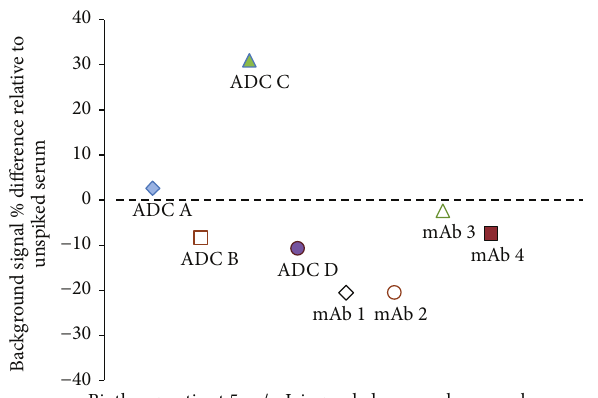
Figure 4: Background signal in pooled cynomolgus monkey serum differs across biotherapeutics in the generic assay. Eight biothera- peutics were added at 5 𝜇 g/mL to a pooled cynomolgus monkey serum and tested in the generic assay. The background signal in the presence of biotherapeutic was compared to the signal in the unspiked sample and the percent difference calculated. The back- ground signals differed across biotherapeutics with % differences compared to the unspiked pooled monkey serum ranging between − 21%and31%.ADC=antibody-drugconjugate;mAb=monoclonal antibody.